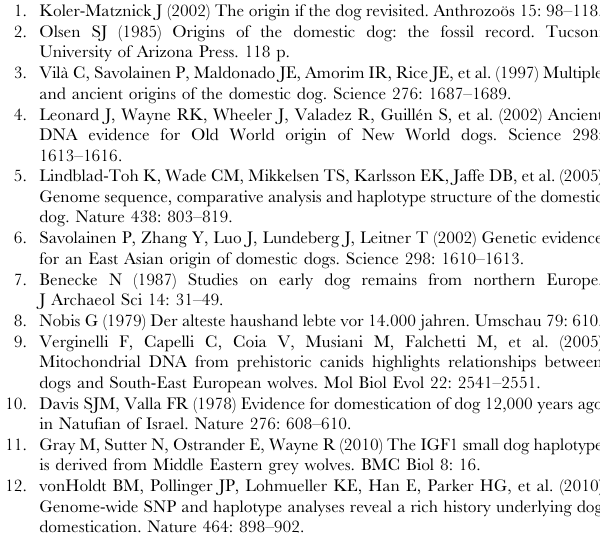
in the priming region associated with this clade. The SNP haplotypes are indicated in Table S6. Table S8 Allelic composition of NRY STR haplotypes and corresponding SNP haplotypes. An asterix identifies a SNP haplotype with one or more positions imputed (see Table S7). Previously published haplotypes are named the same as by Bannasch et al. 2005 a . Table S9 Frequency of NRY STR and SNP haplotypes observed in Middle Eastern and Southeast Asian village dog populations, Australian Dingoes, breed dogs (in- cluding published ones a ), and gray wolves. An asterix identifies a SNP haplotype with one or more positions imputed (see Table S7). Table S10 Breed, number (No.) of individuals, putative region of breed origin a , breed class, and haplotype name of STR haplotypes included in NRY STR and SNP- STR analyses. Parentheses indicate individuals and haplotypes found in breed dogs that were genotyped in the present study and used in SNP-STR analysis; otherwise entries refer to published data b